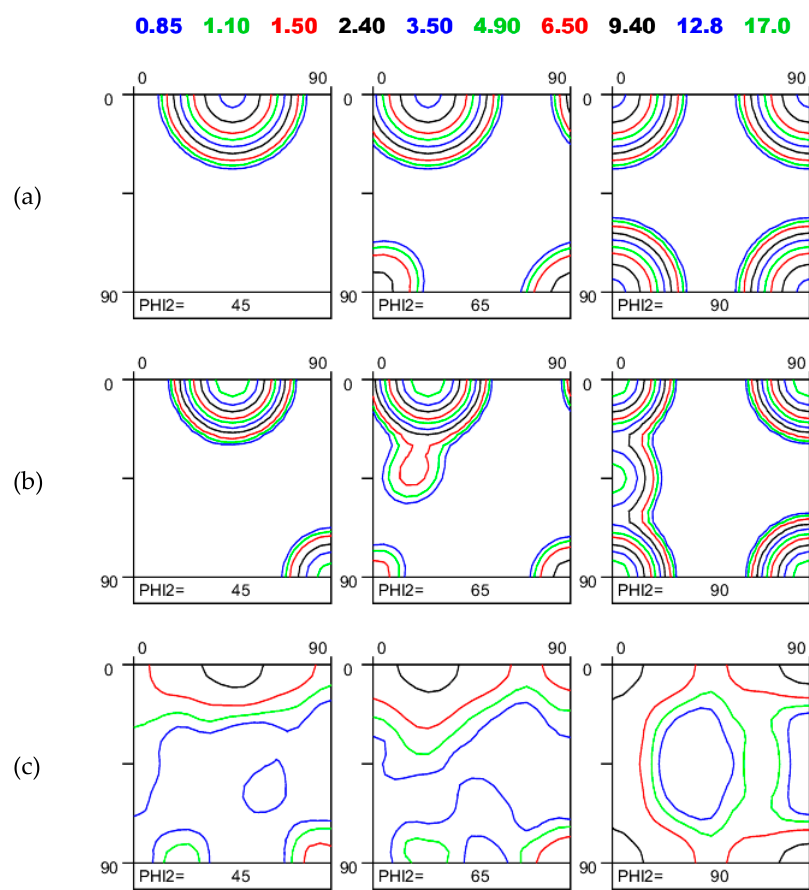
Figure 8. Three texture types used for r -value calculations, presented in Figure 9: ( a ) Cube dominated texture; ( b ) Cube and Goss-type ODF; ( c ) Cube and Goss mixed with the P, Q and weakly developed E orientation.